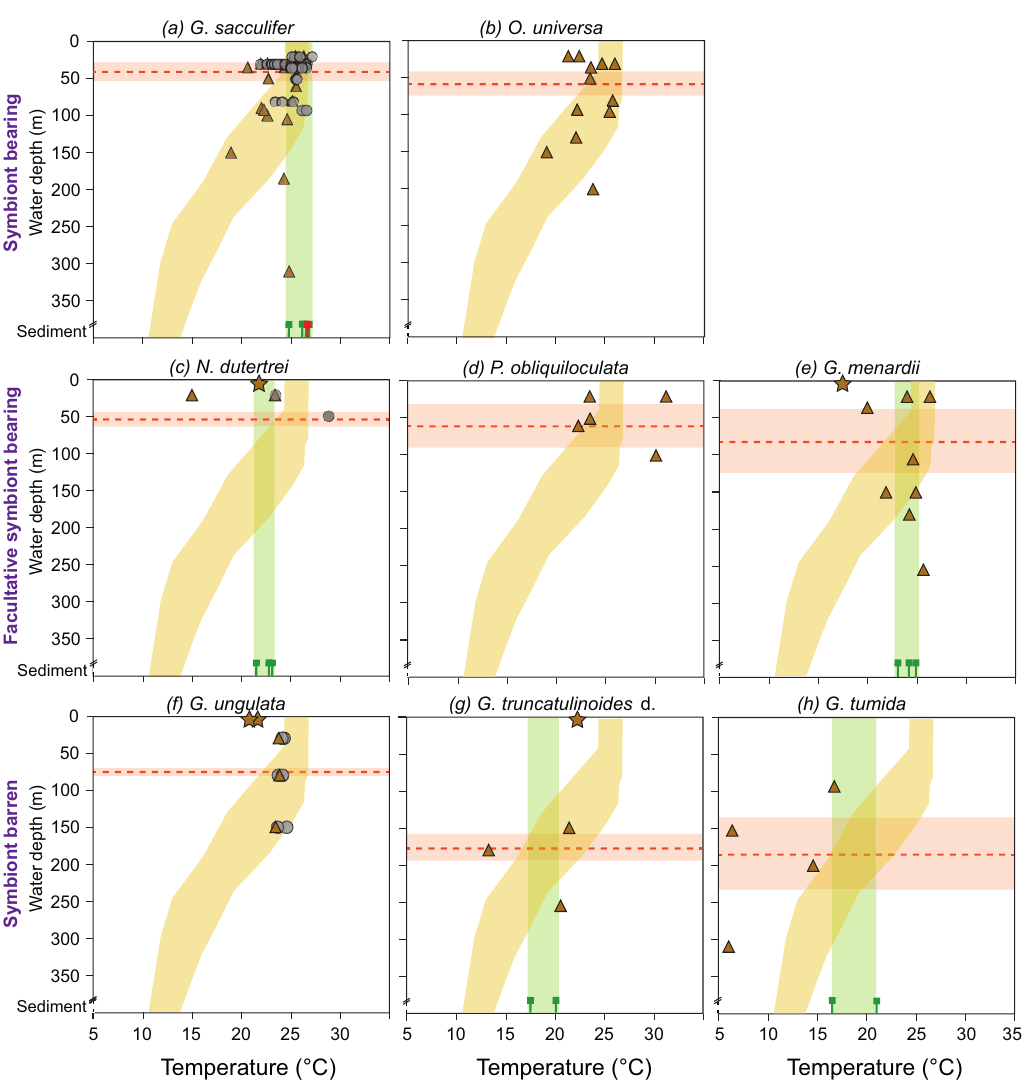
Figure 8. Mg / Ca derived temperature estimates of living planktic foraminifers combined from the Florida Straits, the eastern Gulf of Mexico and the Caribbean Sea in comparison to the ambient seawater temperature. The foraminiferal dataset was differentiated into symbiont- bearing, facultative symbiont-bearing and symbiont barren species from top to bottom (Table 2; see Sect. S1 for data). Grey dots indicate Mg / Ca temperature estimates from bulk foraminiferal MSN samples measured by ICP-OES, depicted at the mean sampling depth intervals. Brown triangles and stars indicate Mg / Ca temperature estimates derived from LA-ICP-MS measurements of single tests from MSN samples (Caribbean Sea and Florida Straits) and PF samples (Gulf of Mexico), respectively (average values; see Sect. S1). Yellow shading indicates temperature envelope ( ◦ C) of the ambient seawater from the Florida Straits and the Caribbean Sea measured during cruise M78/1 (Fig. 2; Schönfeld et al., 2011). Note: PF samples (brown stars) were taken in 3.5m water depth in the eastern Gulf of Mexico at SST of 20 ◦ C during cruise M78/1 (Fig. 1). Green bars indicate Mg / Ca derived temperature range of fossil bulk foraminiferal samples from surface sediments closest to the MSN (green sign indicates the average values of single stations in the Caribbean Sea; red sign indicates the average value of G. sacculifer in the Florida Straits; see Sect. S1). Red dashed lines indicate the average weighted living depths of single species during the sampling campaign in February–March 2009 (red bars are standard deviations; Table 2). Note that all test size fractions are